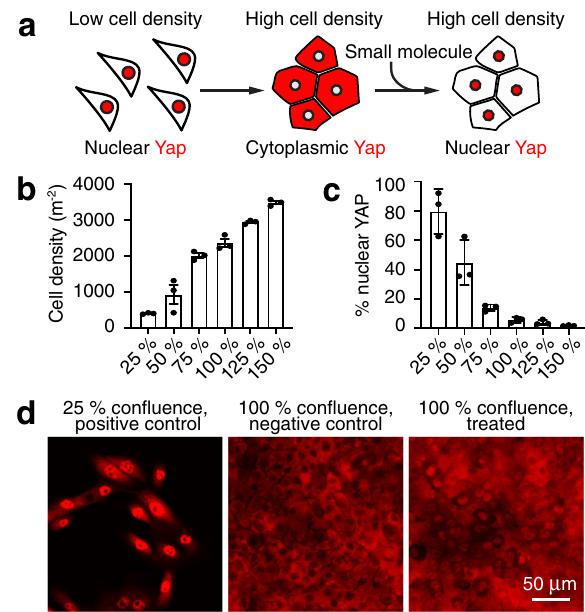
Fig. 1 High-throughput screen for activators of Yap signaling. a A schematic diagram demonstrates the strategy for the identi fi cation of compounds that promote the nuclear transit of Yap, thus reversing the exclusion characteristic of contact inhibition. b The number of MCF 10A cells rises almost linearly with their con fl uency ( n = 3 for each condition, mean ± SEM). c Nuclear localization of Yap falls systematically with increasing con fl uency in MCF 10A cultures ( n = 3 for each condition, mean ± SEM). d Immunolabeling of Yap (red) demonstrates nuclear localization of the protein in a positive-control (subcon fl uent) culture but not in a negative-control (con fl uent) culture. Treatment of a con fl uent culture with a representative hit compound promotes extensive movement of Yap into nuclei. The experiment was conducted four times with the same results. See also Supplementary Fig.